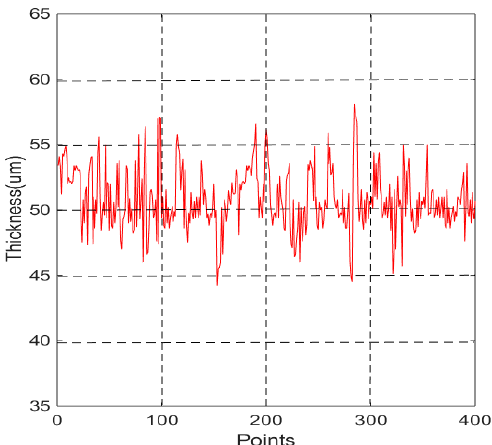
Figure 17. Material Thickness of Random Chosen Points for U-direction Trajectory.